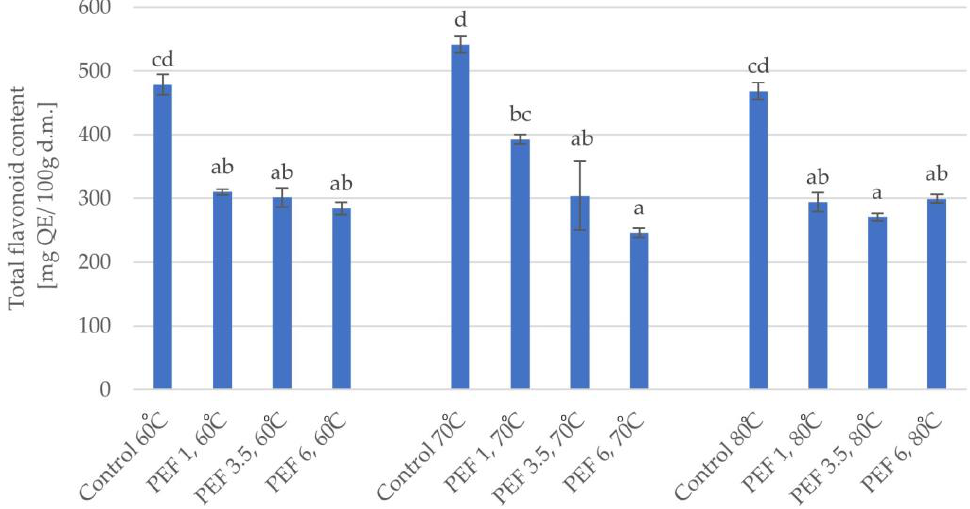
Figure 6. Total flavonoid content of dried apple tissue obtained using different values for the parameters of pulsed electric field intensity (1, 3.5, and 6 kJ/kg) and hot air drying temperature (60, 70, and 80 °C). The columns with different letters are significantly different ( p < 0.05).